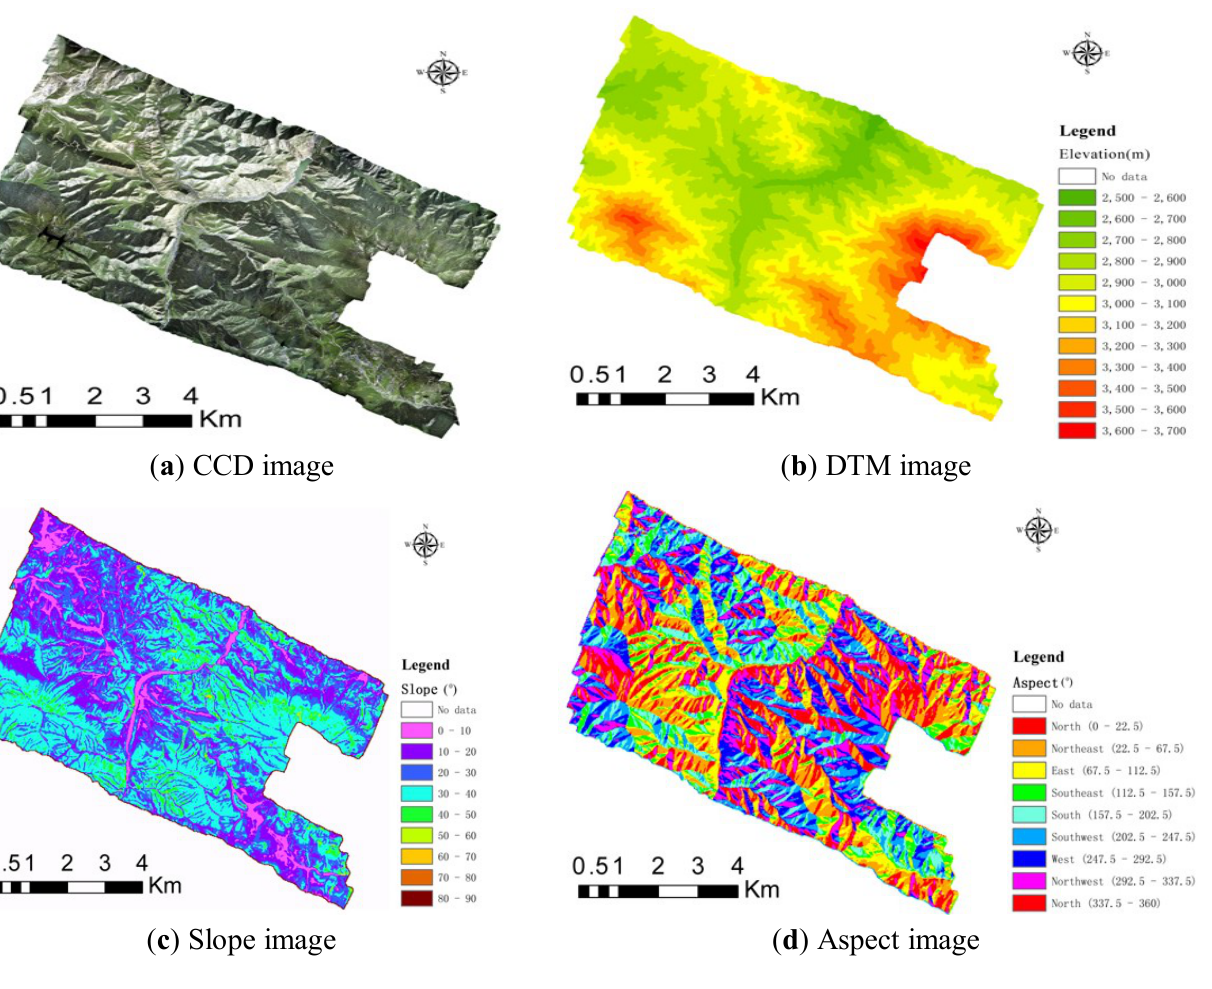
Figure 5. CCD image together with the DTM, Slope, and Aspect images. ( a ) CCD image; ( b ) DTM image; ( c ) Slope image and ( d ) Aspect image.